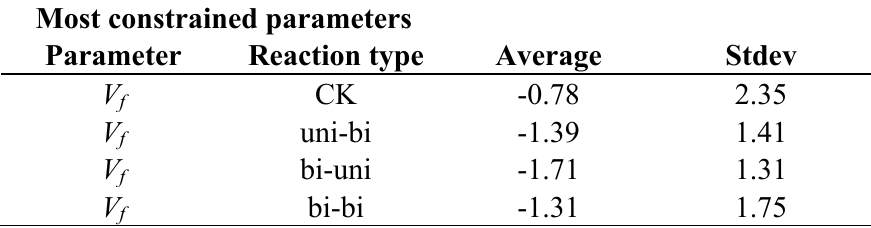
Table 1. Average parameter values and standard deviation (Stdev) for the most constrained parameters in logarithmic scale over 100 iterations of parameter variability analysis